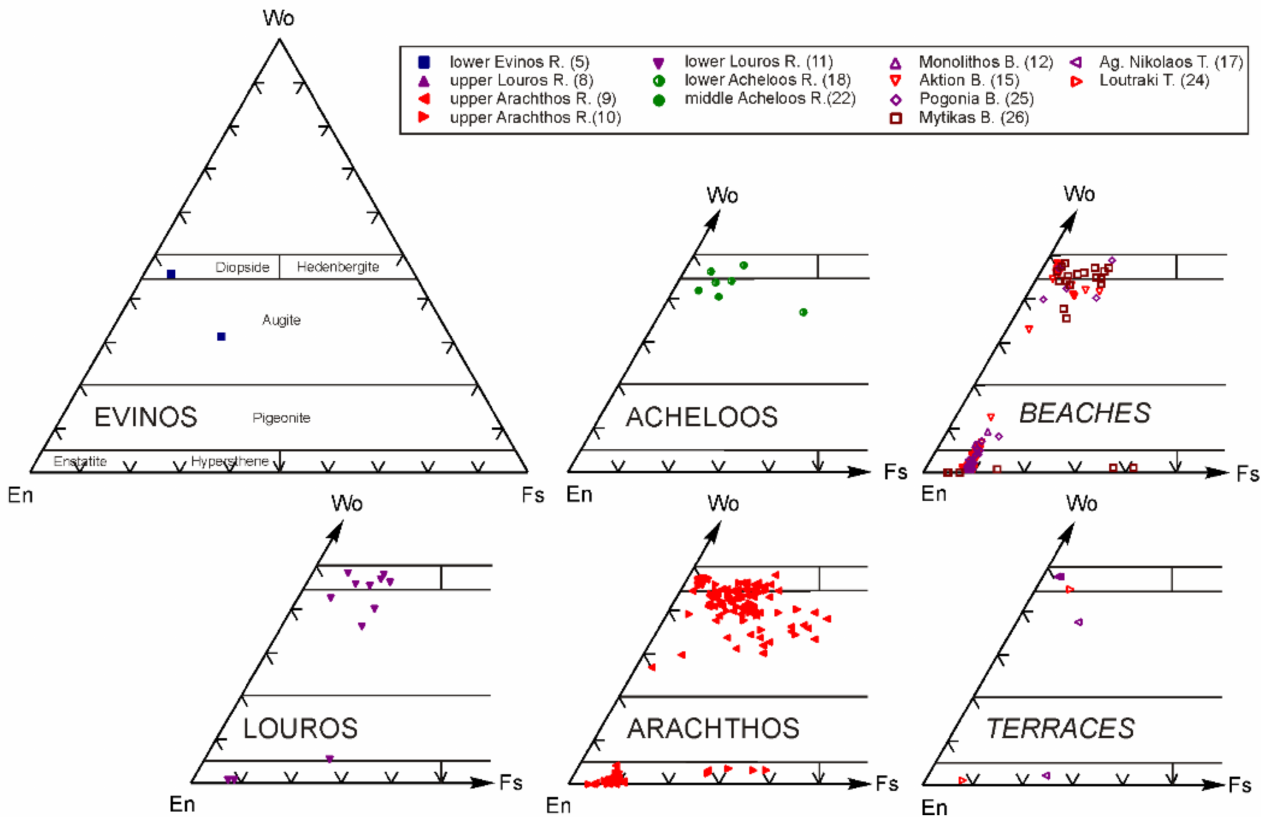
Figure 5. Standard classification diagram for pyroxene [44] based on variation in the end members En = enstatite (Mg); Fs = ferrosilite (Fe); Wo = wollastonite (Ca). Coloured symbols show composi- tional range from each